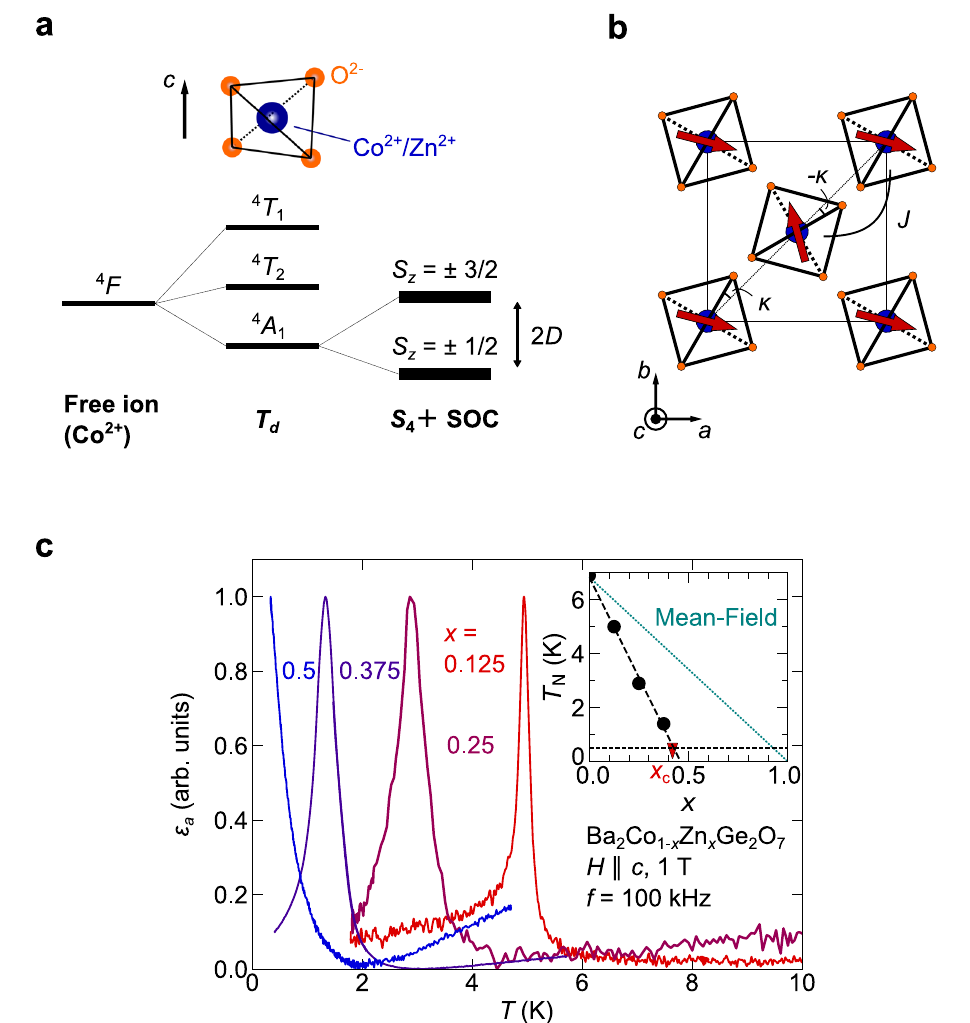
Fig. 2 | Basic physical properties of Ba 2 Co 1 − x Zn x Ge 2 O 7 (BCZGO). a Energy level splitting of 3 d electrons at Co 2+ . The free-ion state splits into three levels in the T d crystal fi eld environment. The lowest four-fold degenerate 4 A 1 state can be describedby S =3/2witheasy-planeanisotropy( D ^ S 2 z )duetothe S 4 crystal fi eldand spin-orbitcoupling(SOC). b SchematicmagneticstructureofBa 2 CoGe 2 O 7 (BCGO). Red arrows represent spin orientations in the ordered phase. The spin canting is exaggerated from the actual angle for visibility (see Supplementary Note